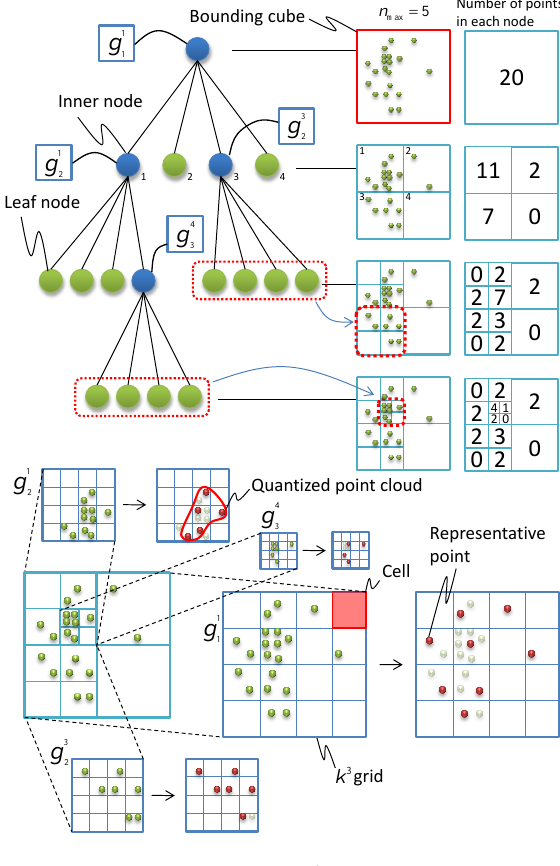
Figure 3. Octree and quantization